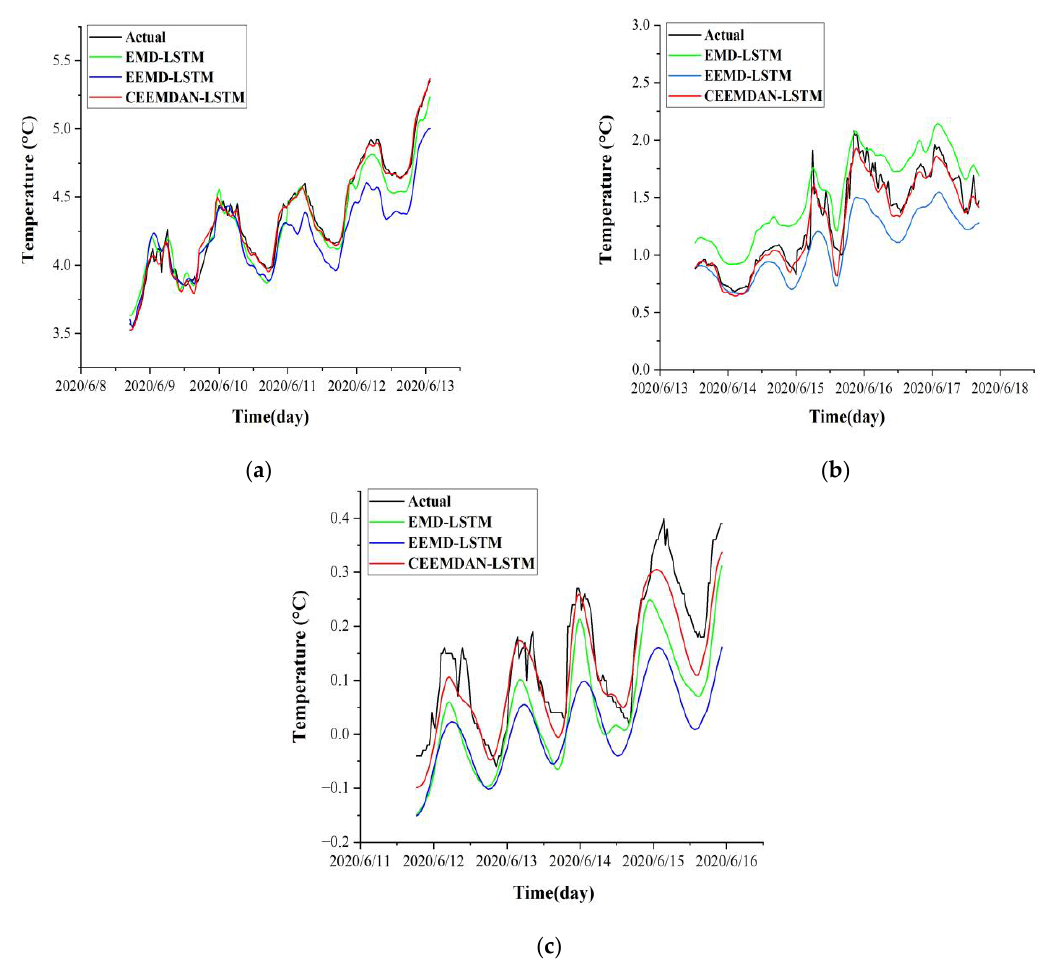
Figure 11. Results of temperature decomposed by CEEMDAN at different subgrade depths. ( a ) 0.5 m depth; ( b ) 1.5 m depth; ( c ) 2.9 m depths.